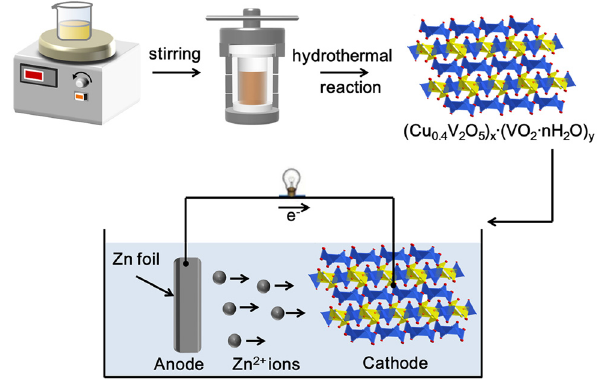
Figure 1: Schematic diagram of the synthesis of ( Cu ) x ·( VO · n H ) y nanosheets in this 0.4 V 2 O 5 2 2 O